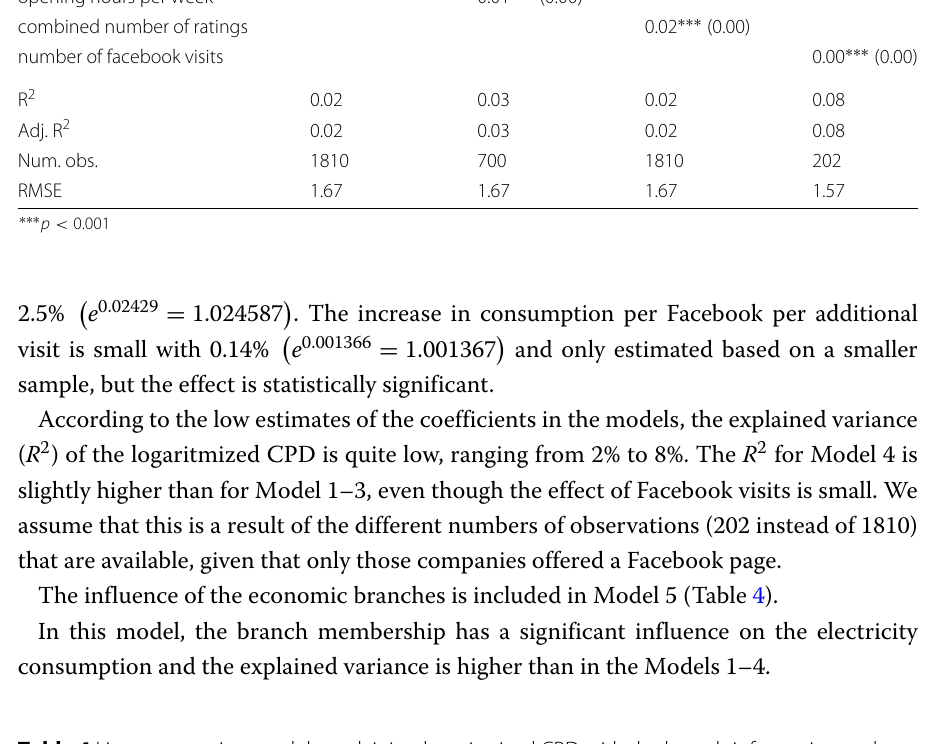
Table 4 Linear regression models explaining logaritmized CPD with the branch information and combined models with multiple influencing factor Model